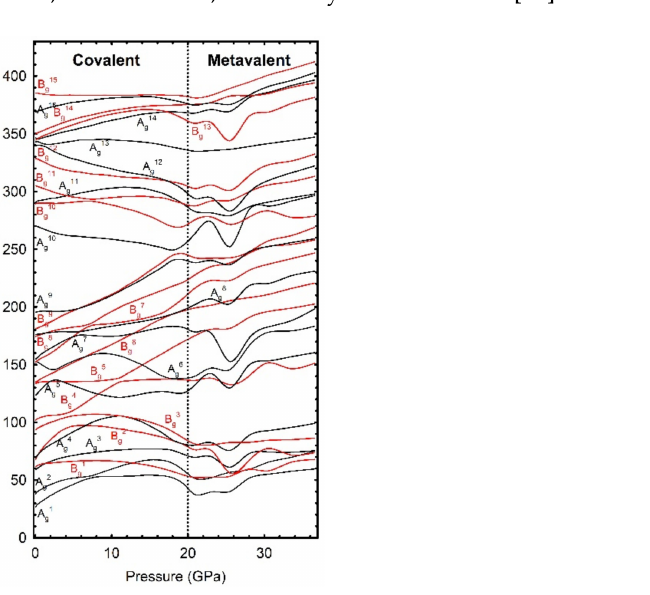
Figure 6. Pressure dependence of the theoretical Raman-active modes in orpiment. Black (red) lines correspond to A g (B g ) modes. A superindex has been added to all Raman-active modes in order of increasing frequency. The dotted line separates the pressure regions with mainly covalent and metavalent